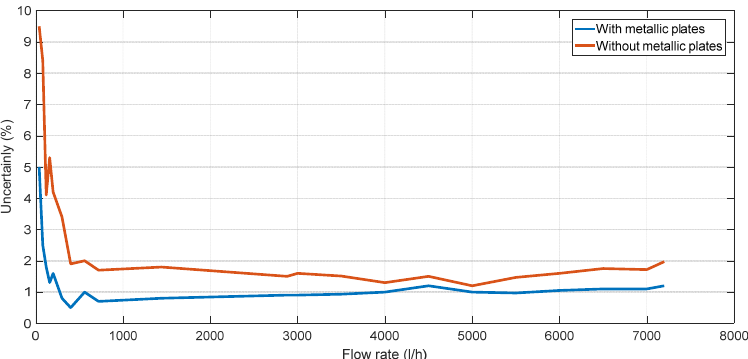
Figure 10. Uncertainty achieved with and without lamination.